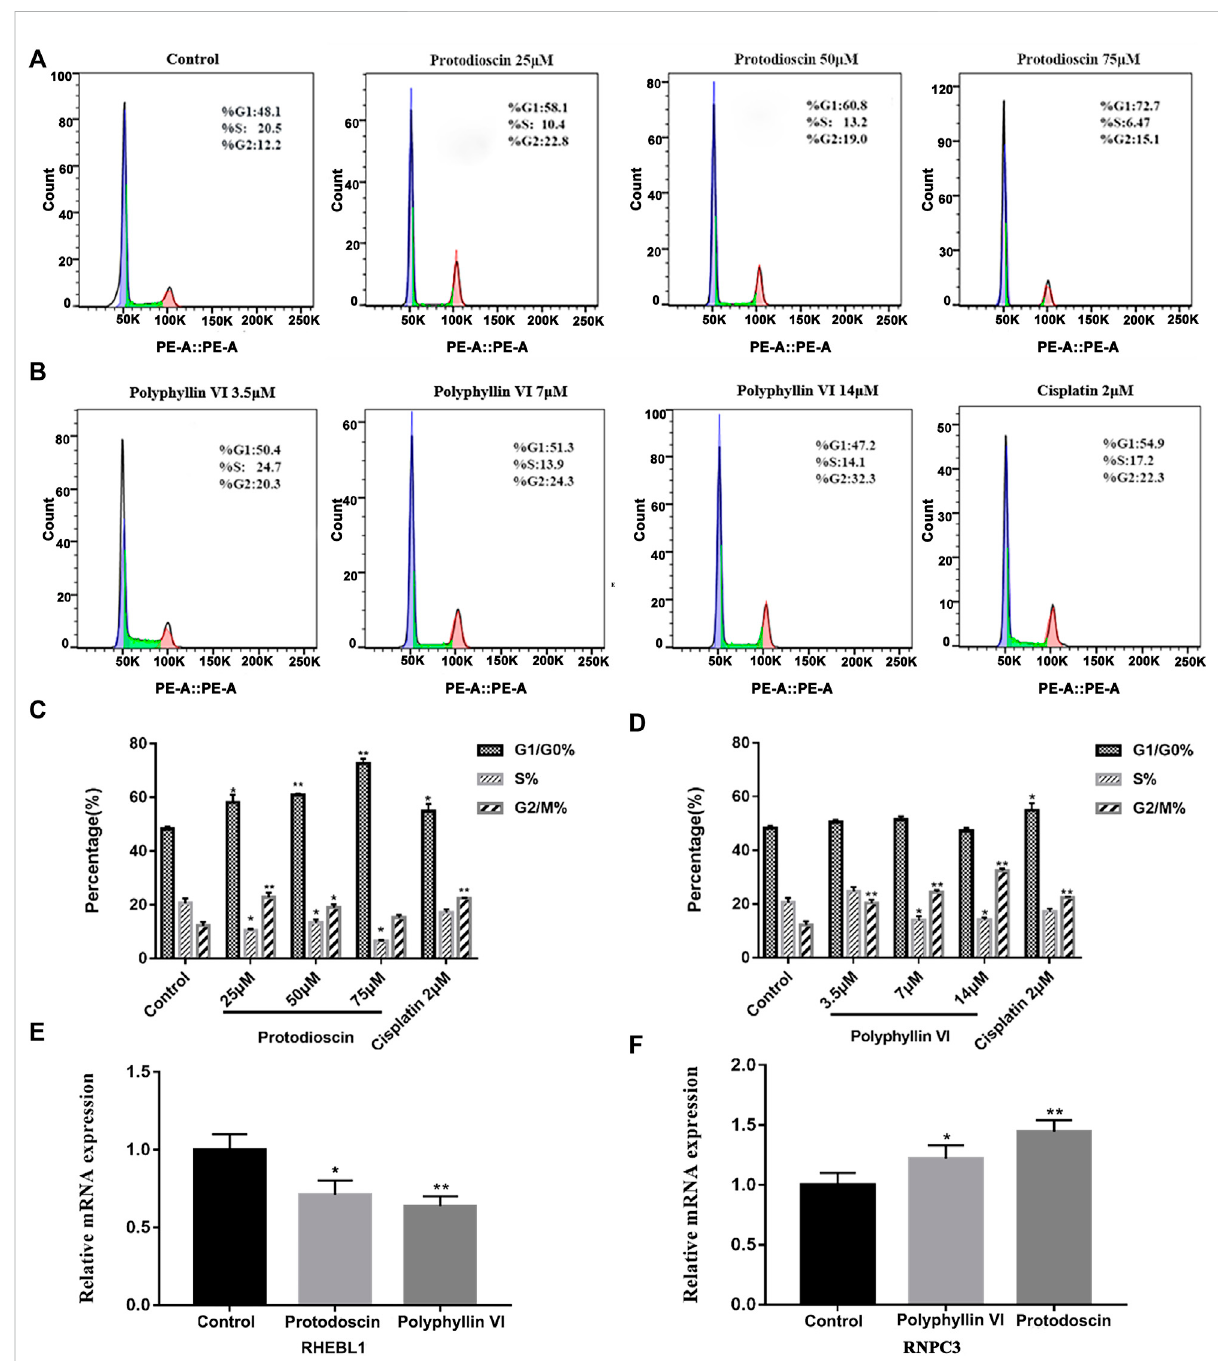
FIGURE 9 Polyphyllin VI and protodioscin induce cell cycle arrest in A549 cells and the effect on mRNA expression of RHEBL1 and RNPC3 in this cell line. (A,B) The cell cycle distribution map of A549 cells exposure to Polyphyllin VI, Protodioscin and Cisplatin for 48 h was detected by fl ow cytometry. (C,D) The data show that Protodioscin (concentration-dependent manner) and Cisplatin signi fi cantly increase the ratio of cells in G1/G0 phase. However, Polyphyllin VI (concentration-dependent manner) signi fi cantly increase the ratio of cells in G2/M phase. * p < 0.05, ** p < 0.01 compared with the control group. Each column represents the mean ± SD of three independent experiments. (E) RHEBL1 expression was signi fi cantly down-regulated in A549 cells treated with Protodioscin (50 μ M) and Polyphyllin VI (3.5 μ M) for 48 h; (F) RNPC3 expression was signi fi cantly upregulatedinA549cellsafter 48 htreatmentwithProtodioscin(50 μ M)andPolyphyllinVI(3.5 μ M).(Resultswereanalyzedusing2 − ΔΔ CT Method, * p < 0.05, ** p < 0.01, compared with the control group. Each column represents the mean ± SD of three independent